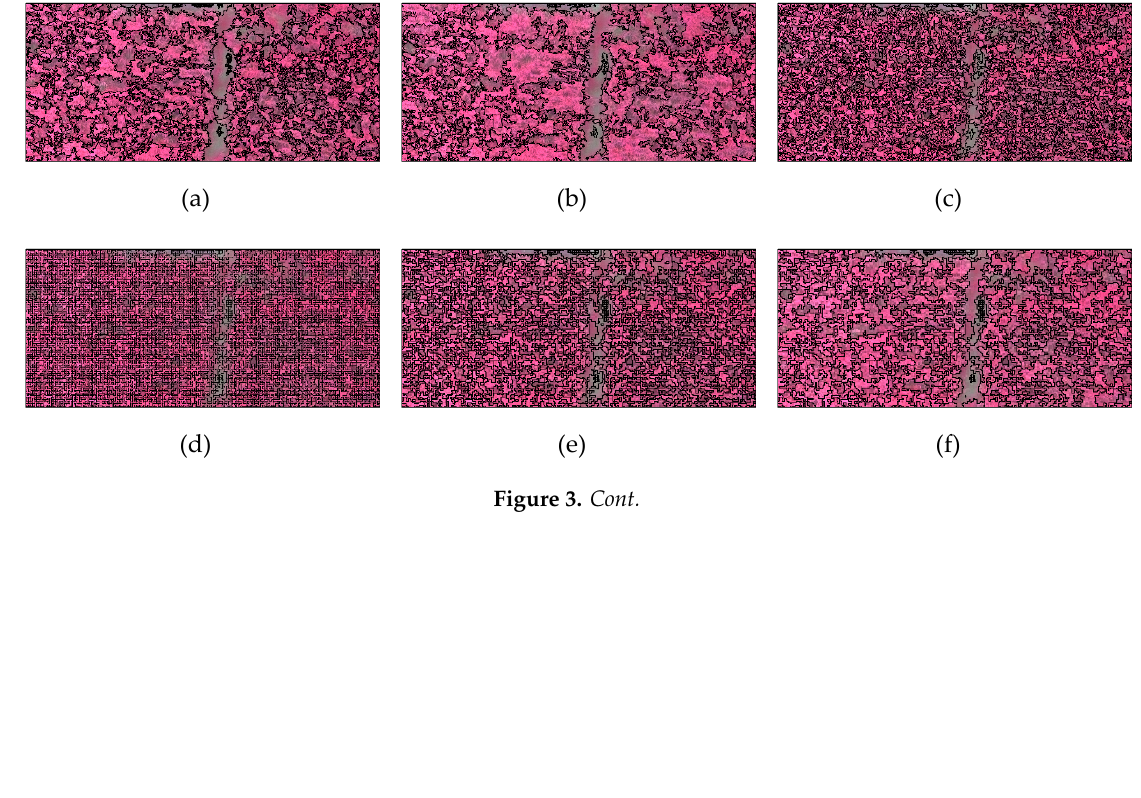
Table 5. Appropriate scale parameters for secondary segmentation of multi-scale images.